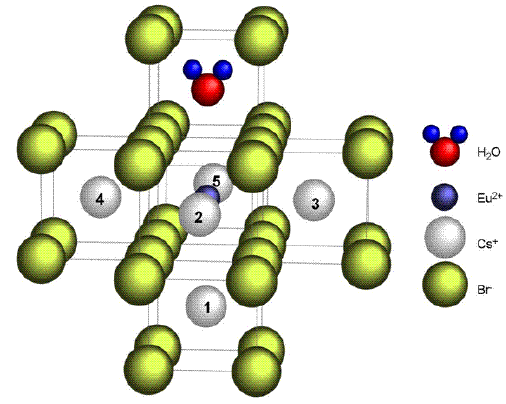
Figure 29. Possible models for the luminescent centers in annealed CsBr:Eu 2+ [98] (reproduced with permission from Frank